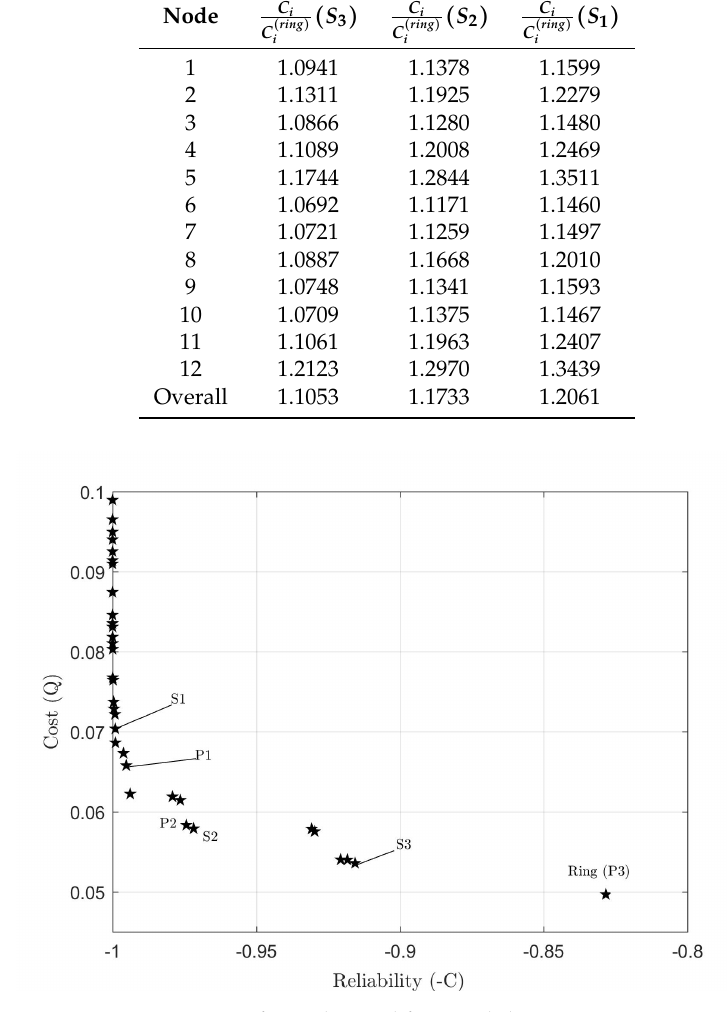
Figure 2. Pareto front obtained for weightless